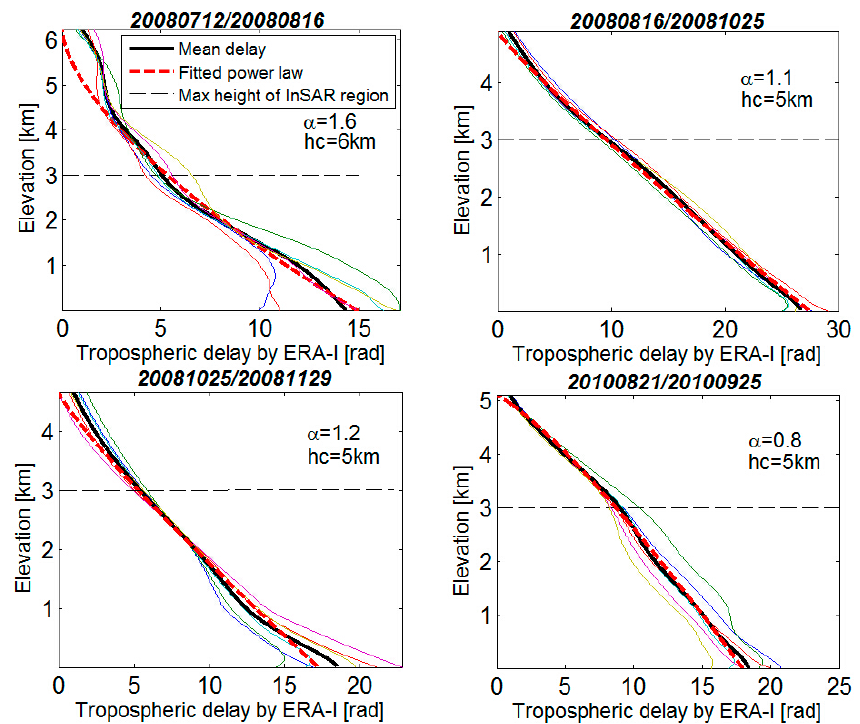
h and power law coe ffi cient  for our study area in Figure 6. Examples of constrained height c Figure 6. Examples of constrained height h c and power law coefficient α for our study area in California. h to the altitude for which the California. Both coe ffi cients were estimated by using ERA-I. We set c Both coefficients were estimated by using ERA-I. We set h c to the altitude for which the STD and average STD and average value of the relative delay offsets are both less than 1.0 rad (~0.45 cm). value of the relative delay offsets are both less than 1.0 rad (~0.45